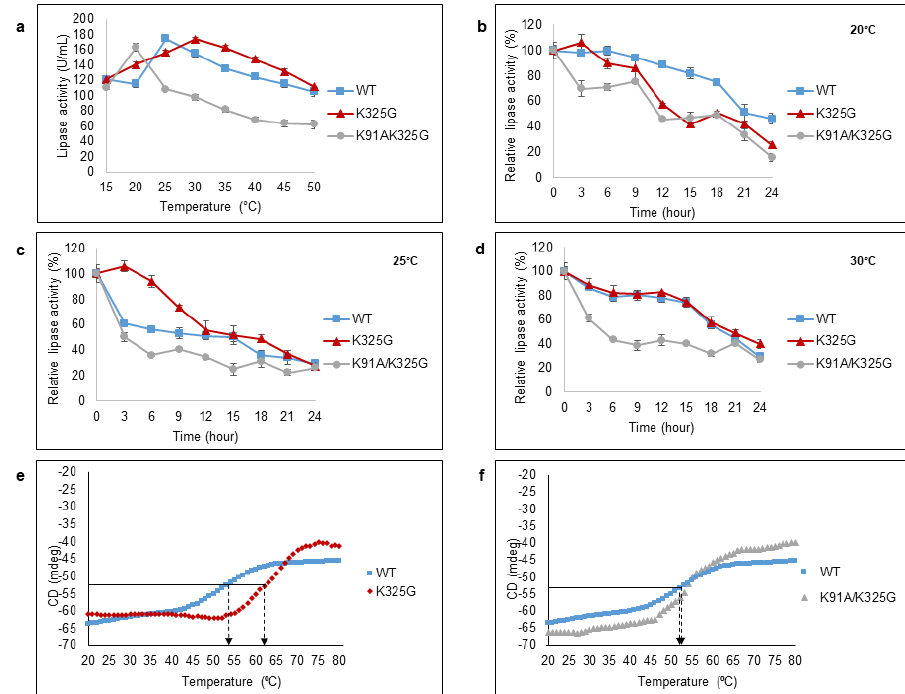
Figure 6. Effect of temperature on purified WT, K325G, and K91A/K325G lipase ( a ) activity and ( b – d ) half-life. Optimal temperature was determined by varying assay temperatures (15°C to 50°C). As for half-life, each lipase was incubated at different temperatures; 20 °C, 25 °C, and 30 °C for 24 h. The remaining activity was assayed at their optimal temperature. The protein concentration of each tested lipase was standardised to 0.5 mg/mL. Relative activity was calculated based on the control of the experiment. Non-incubated sample was regarded as the control (100%). Error bars denote the standard deviation of means ( n = 3). Thermal unfolding (T m ) curve of the WT with ( e ) K325G and ( f ) K91A/K325G. Heating rate was 1°C min -1 . The arrows indicate the point of thermal unfolding of each enzyme. Symbols represent as follows; ( ■ ) WT, ( ♦ ) K325G, and ( ▲ ) K91A/K325G.